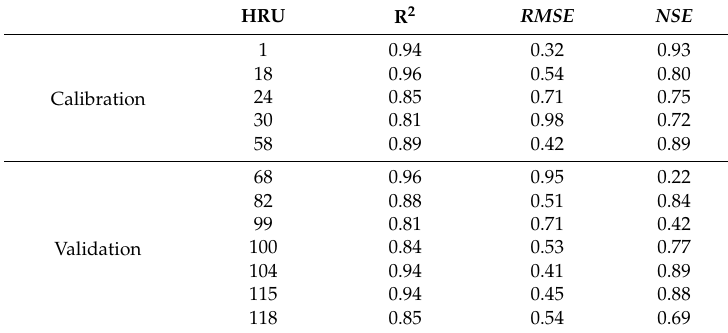
Table 8. Statistical parameters related to the simulation of LAI in the calibration and validation phases.